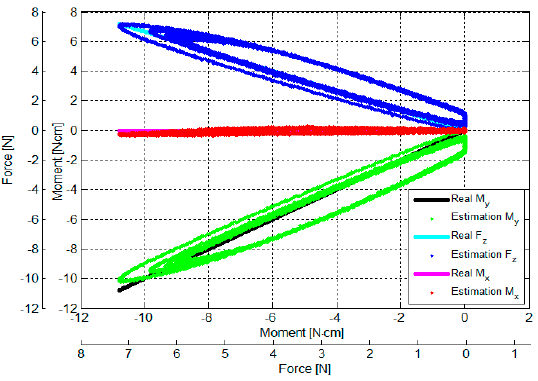
Figure 16. Comparison between real ( F z , M y ) values and estimated ( F z , M y ): external force was applied to and released from point ③ obtained by the sensor calibration device as shown in Figure 12.